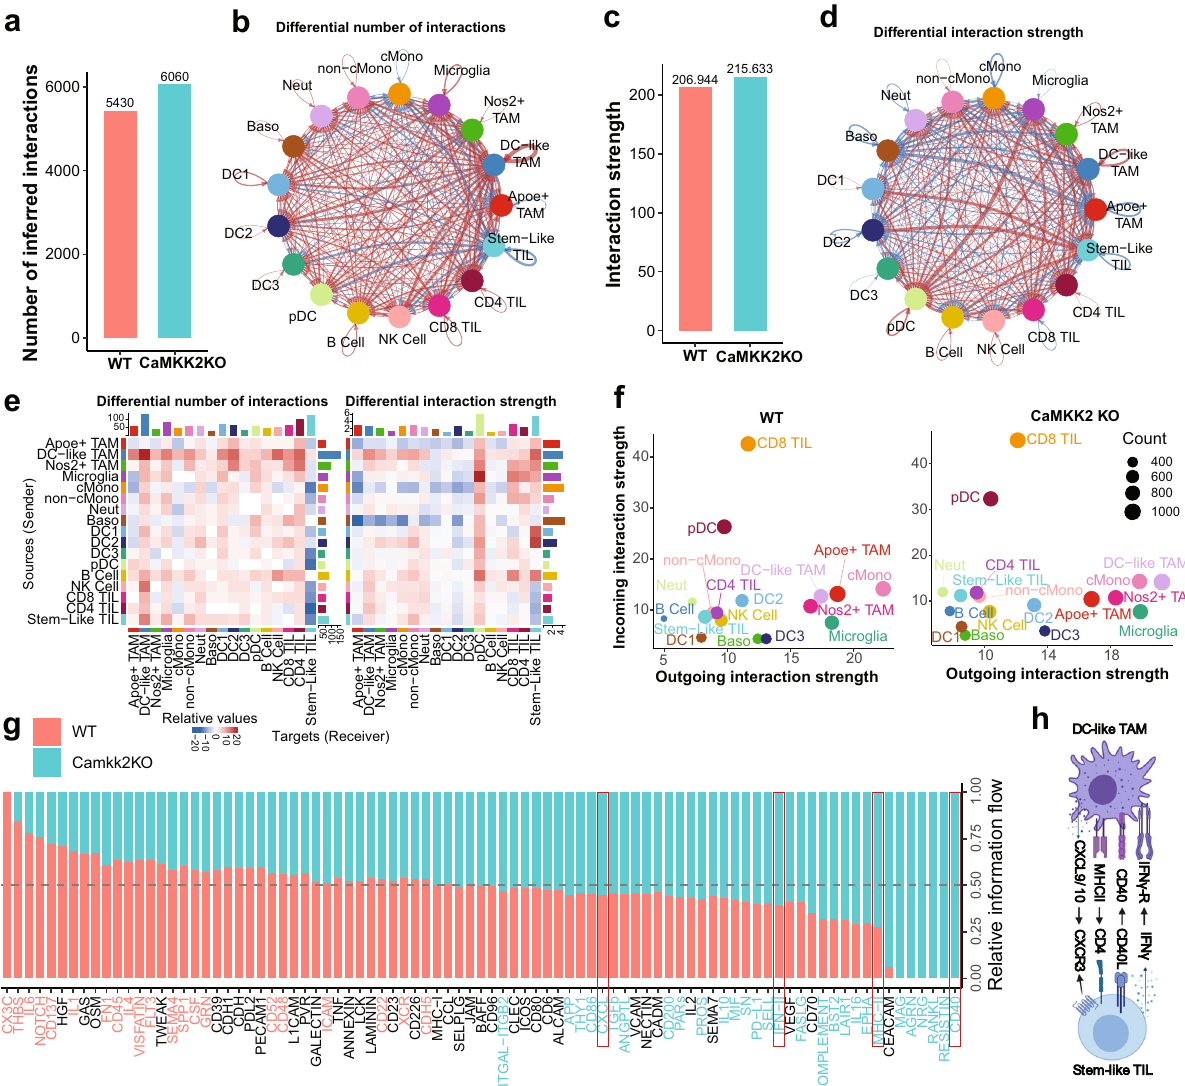
Fig.4|Cell – cellinteractionanalysisinferscommunicationbetweenCD4 + stem- like T cellsand DC-likeTAMsin thesetting ofCaMKK2 de fi ciency. a , c Cell – cell interaction analysis was performed on the scRNA-seq dataset using CellChat. Interaction strength represents the probability that a cell is sending or receiving a signal based on its expression of either ligands or cognate receptors, respectively. Total number of interactions and interaction strength of the inferred cell – cell communication networks for each genotype. b , d Differential number of interac- tionsorinteractionstrengthinthecell – cellcommunicationnetwork,visualizedasa circle plot, where red or blue colored edges represent increased or decreased signalinginCaMKK2KOcomparedtoWT.Linethicknessanddarknessindicatethe relative enrichment value. e Differential number of interactions or interaction strength, visualized as a heatmap, where red or blue represents increased or